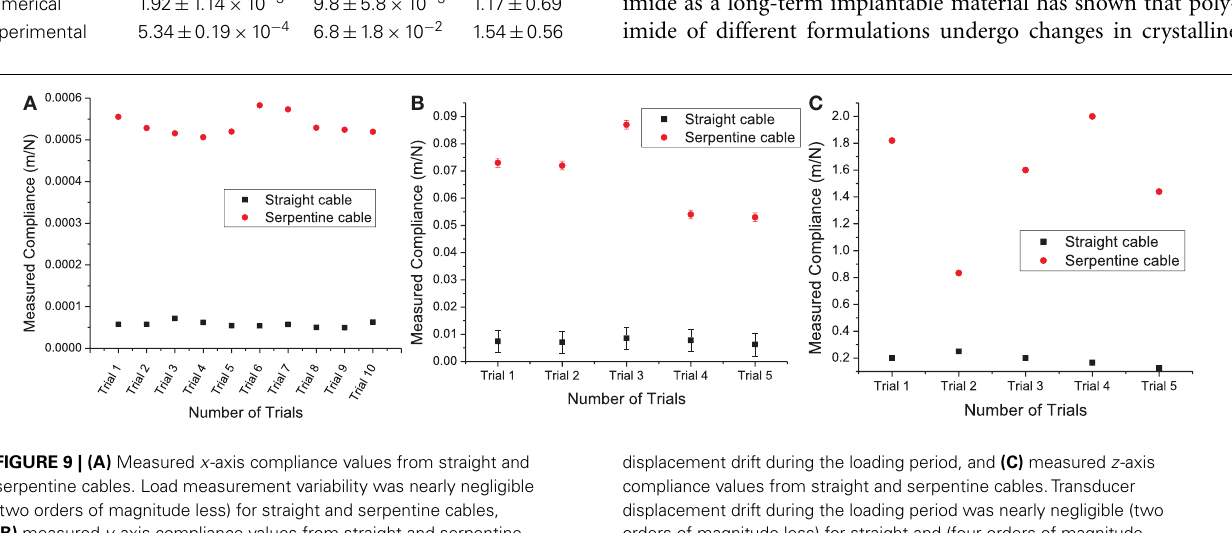
FIGURE 9 | (A) Measured x -axis compliance values from straight and serpentine cables. Load measurement variability was nearly negligible (two orders of magnitude less) for straight and serpentine cables, (B) measured y -axis compliance values from straight and serpentine cables.The error bars represent the variability due to transducer